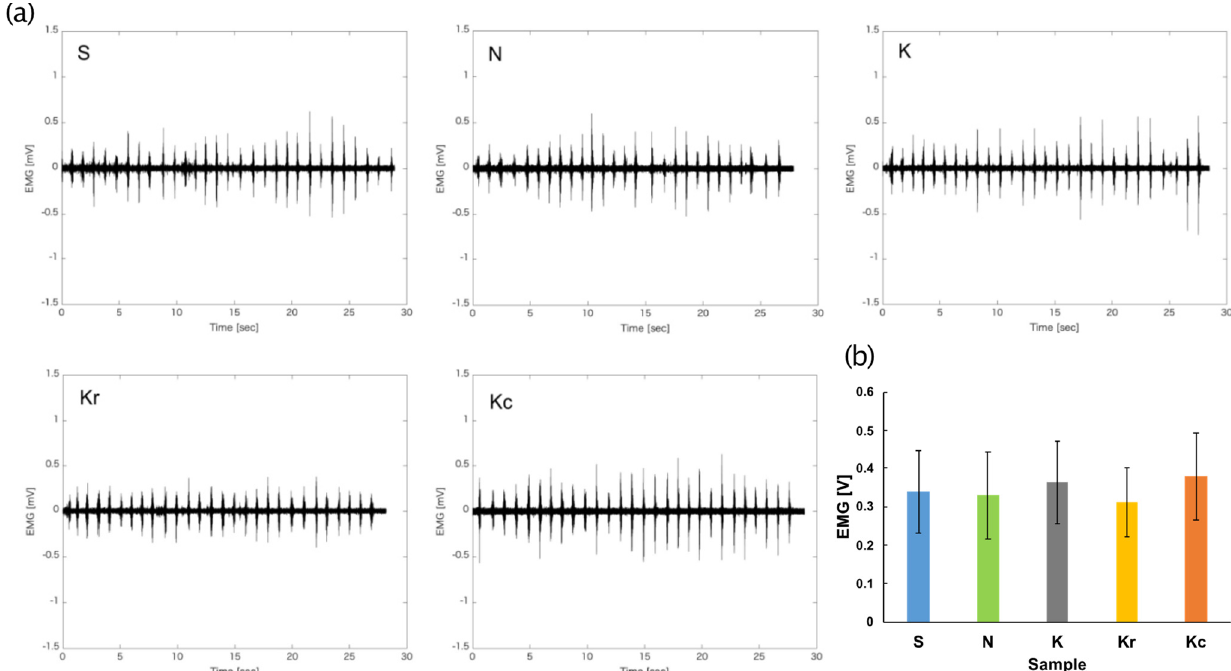
Figure 12. Results of the EMG recording session in Experiment 2. ( a ) Examples from a single participant during the mastication of the samples. ( b ) Mean peak voltage of the EMG of the first mastication in each trial for each sample. Samples S, K, and N are available commercially and produced by different manufactures. Sample Kr was a moisturized and re-dried version of K, and Kc was a crushed version of K. EMG, electromyography.